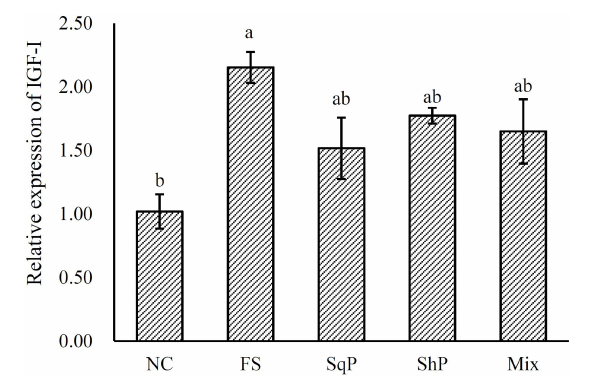
FIGURE 1 | Relative expression of hepatic insulin-like growth factor I (IGF-I) gene of largemouth bass fed the experimental diets for 81 days. Values (means ± standard error of the mean, SEM) in bars that have the same letter are not significantly different ( P > 0.05; Tukey’s test) among treatments ( N = 3).